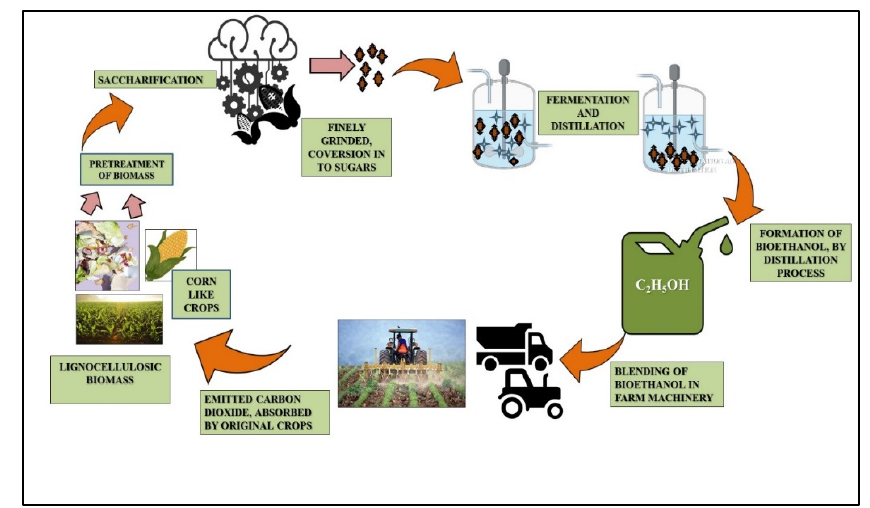
Figure 2. Production process of bioethanol and its blending with conventional fuels.